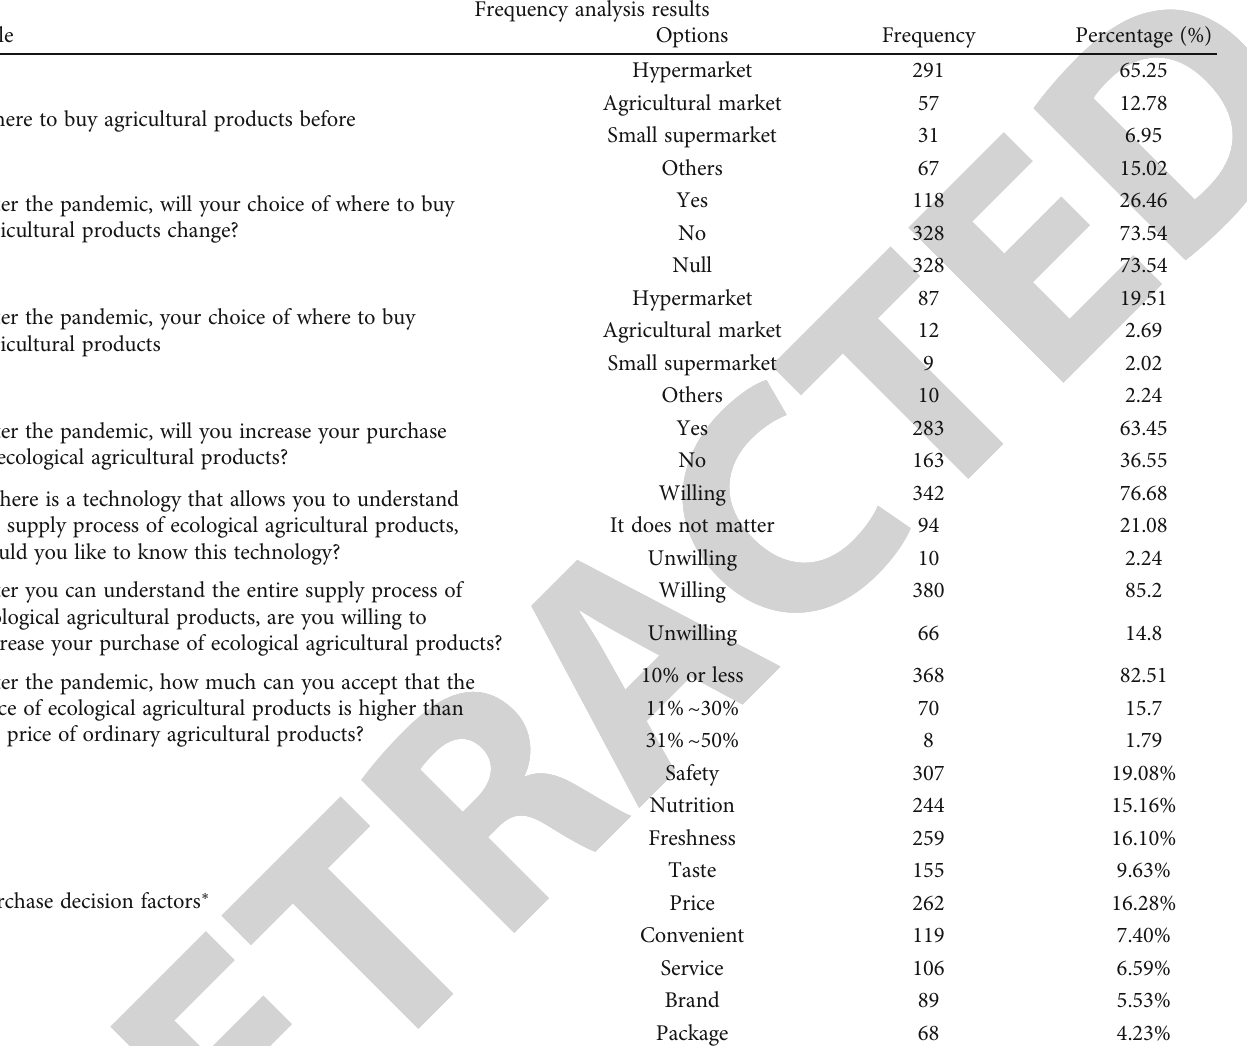
Table 4: Consumer behavior of ecological agricultural